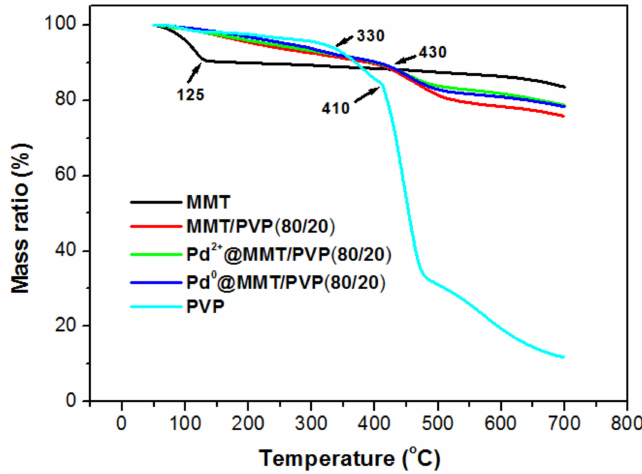
Figure 5. TGA curves of MMT, PVP and Pd@MMT/PVP catalytic